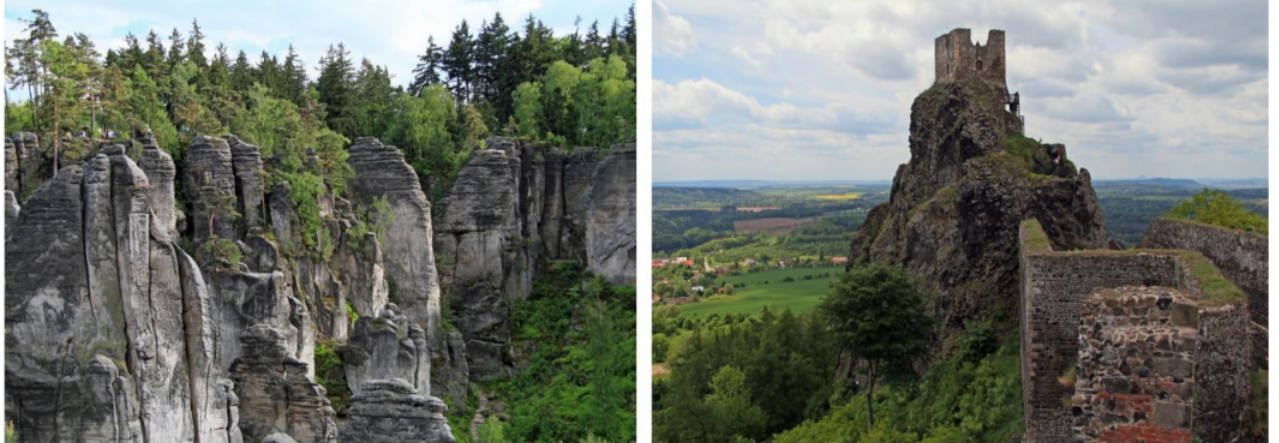
Figure 2. An example of two types of the most visited localities in the Bohemian Paradise UNESCO Global Geopark: sandstone rock formations in Prachov ( left ) and the ruins of Trosky Castle ( right